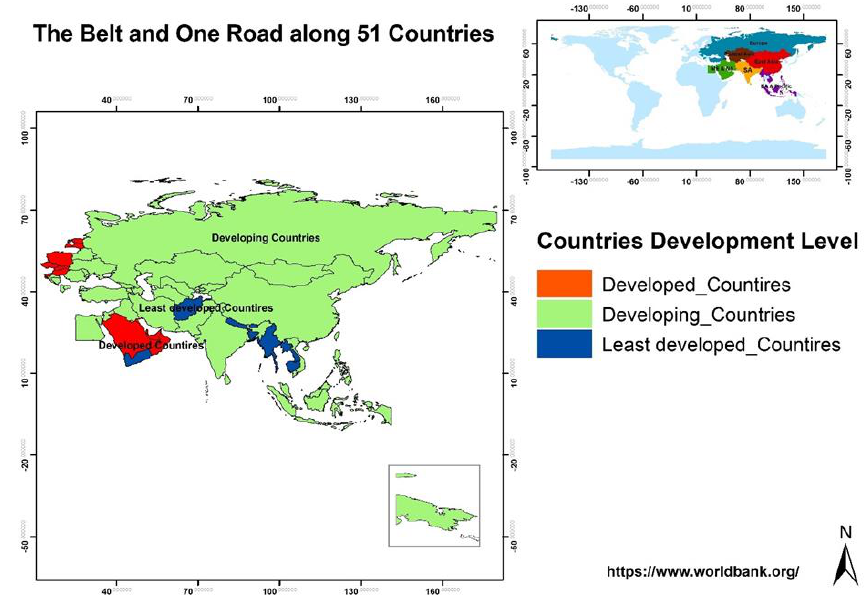
Figure 1. Location of study area.